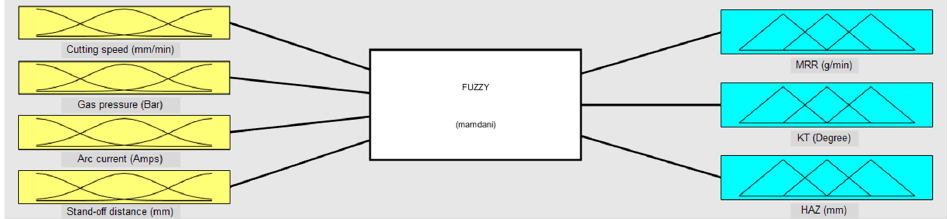
Figure 5. Model representation of PAC input variables and output responses using the Mamdani